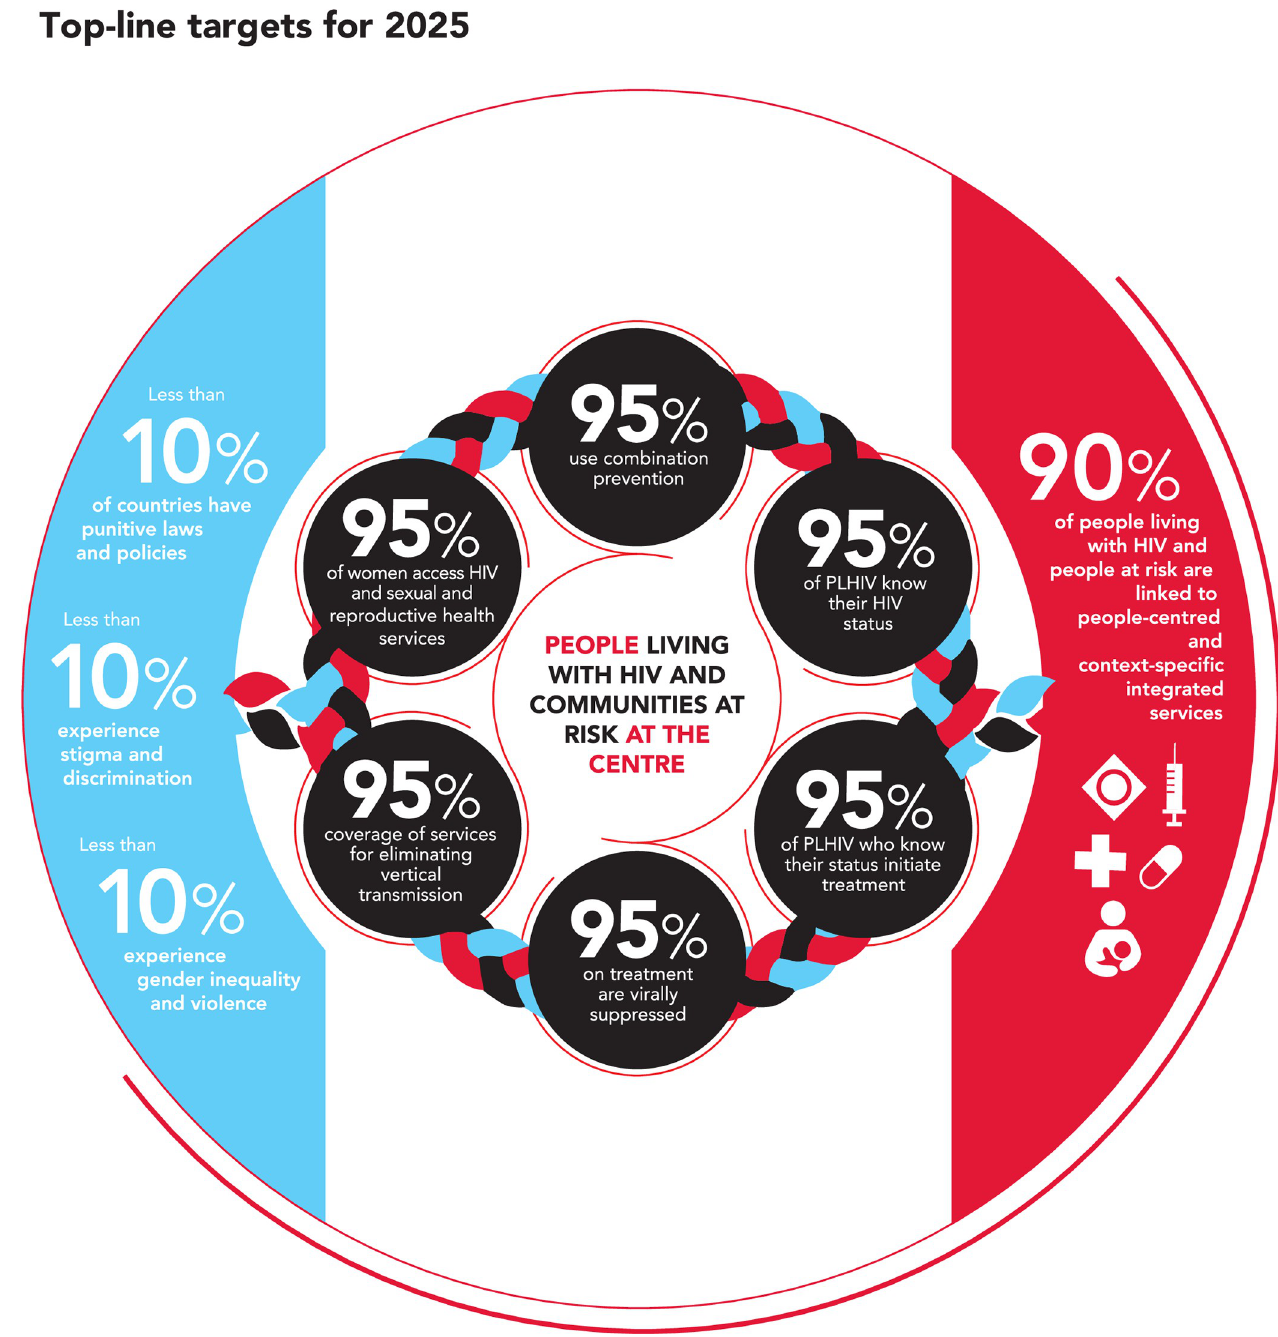
Fig 1. The UNAIDS 2025 Targets for the HIV response. The global targets for the HIV response, accepted by the UN, to be reached by 2025 include HIV services, Societal enablers, and Integration elements.